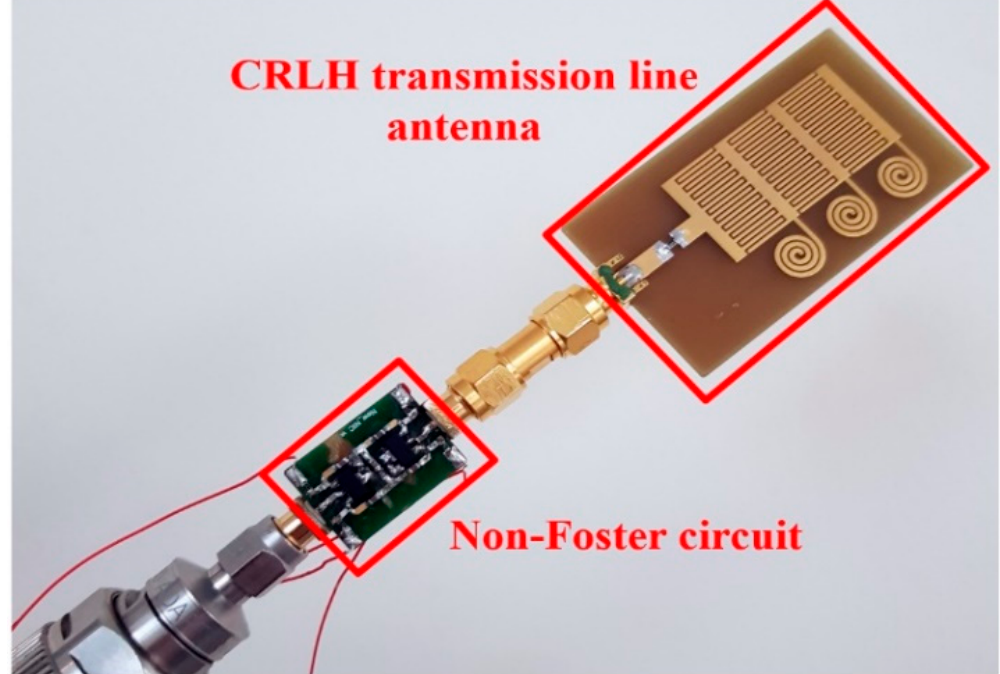
Figure 14. Designed CRLH transmission line antenna.